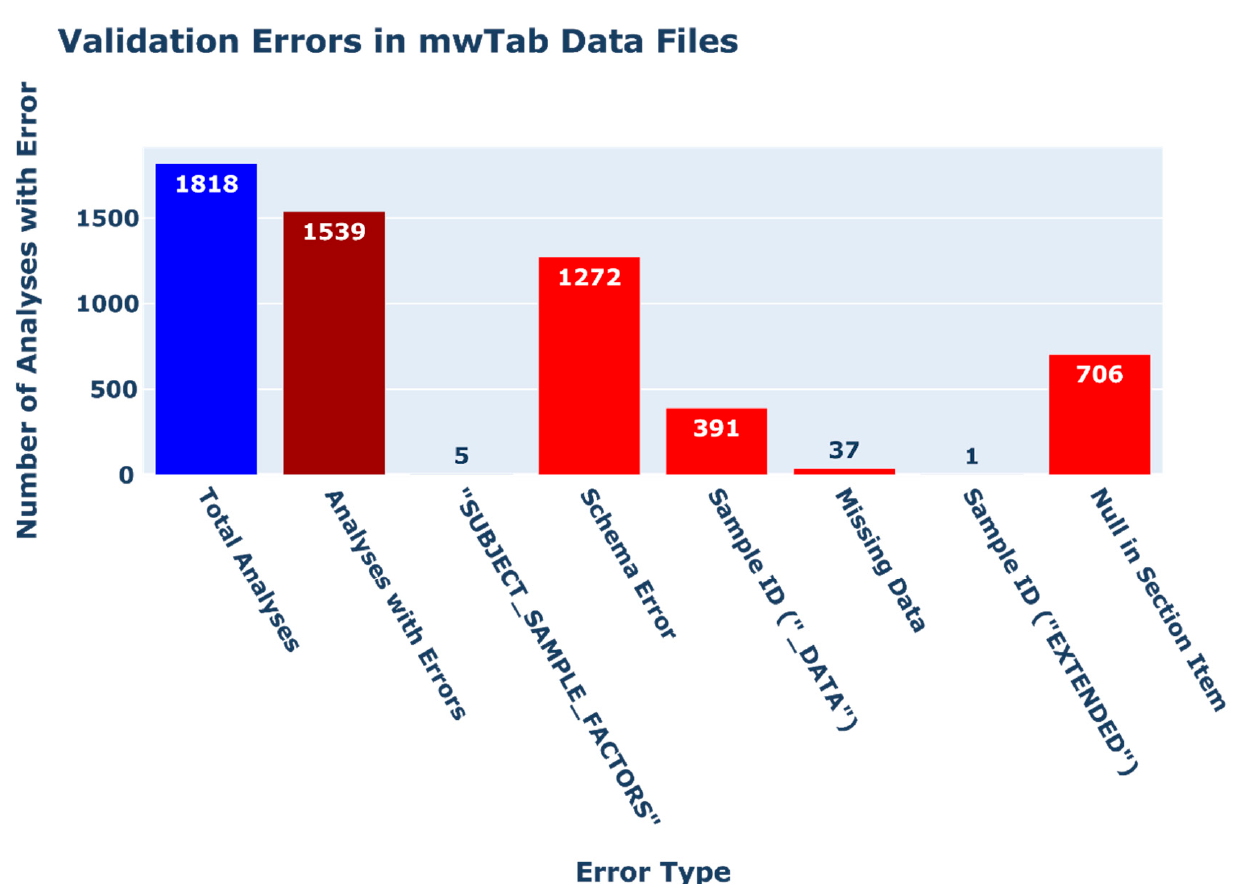
Figure 2. Bar chart depicting the count of validation errors in ‘mwTab’ formatted data files. The total number of analyses for which ‘mwTab’ files were available upon download and could be parsed into ‘~mwtab.mwtab.MWTabFile’ objects is shown in blue on the left. The total number of analyses with validation errors is shown in dark red second from the left. The remaining red bars show the number of analyses which possess each given error type.